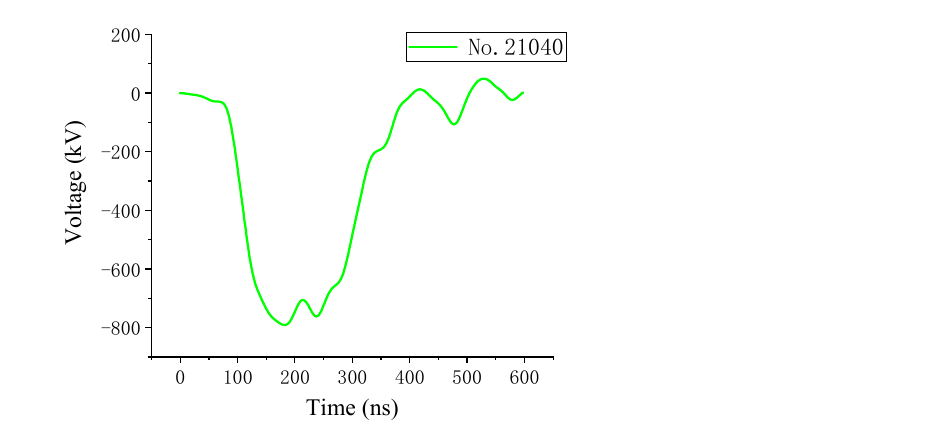
Figure 6. Electron beam voltage waveform (No. 21040).